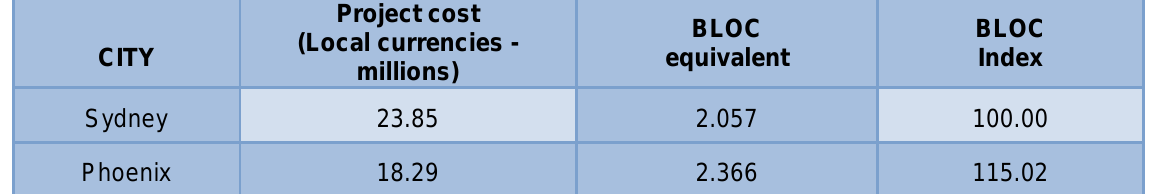
Table 3 Project costs for Sydney and Phoenix expressed in local currencies and BLOC equivalents, and BLOC Index values derived from those BLOC